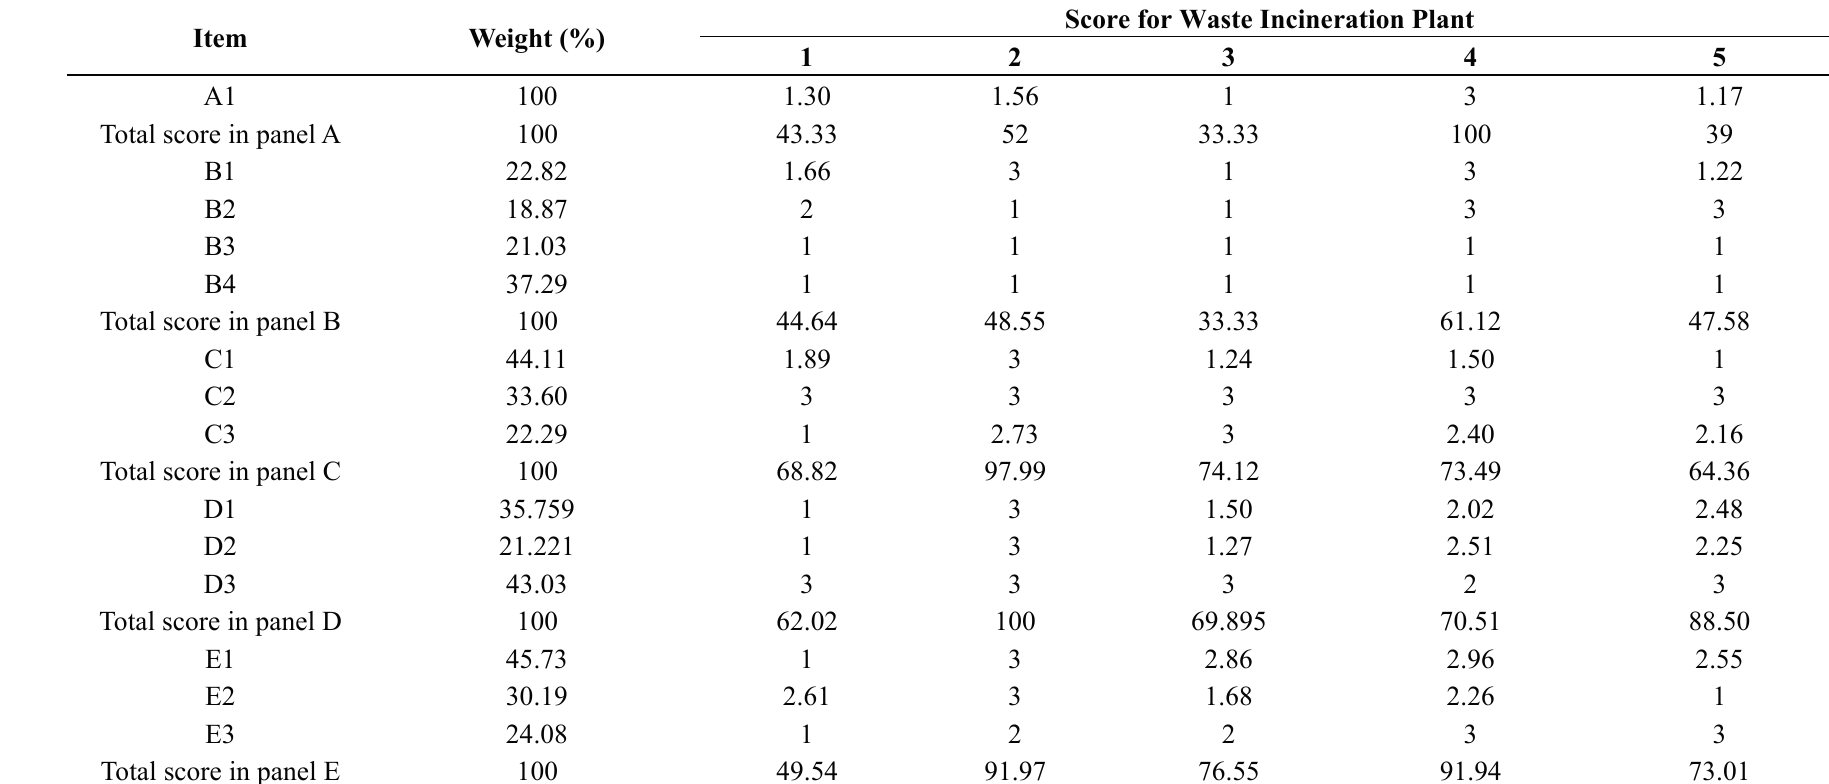
Table 5. The scores of various